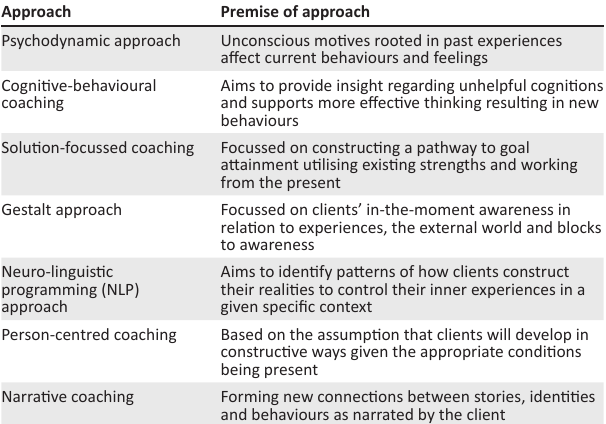
TABLE 1: An overview of a number of evidence-based approaches to